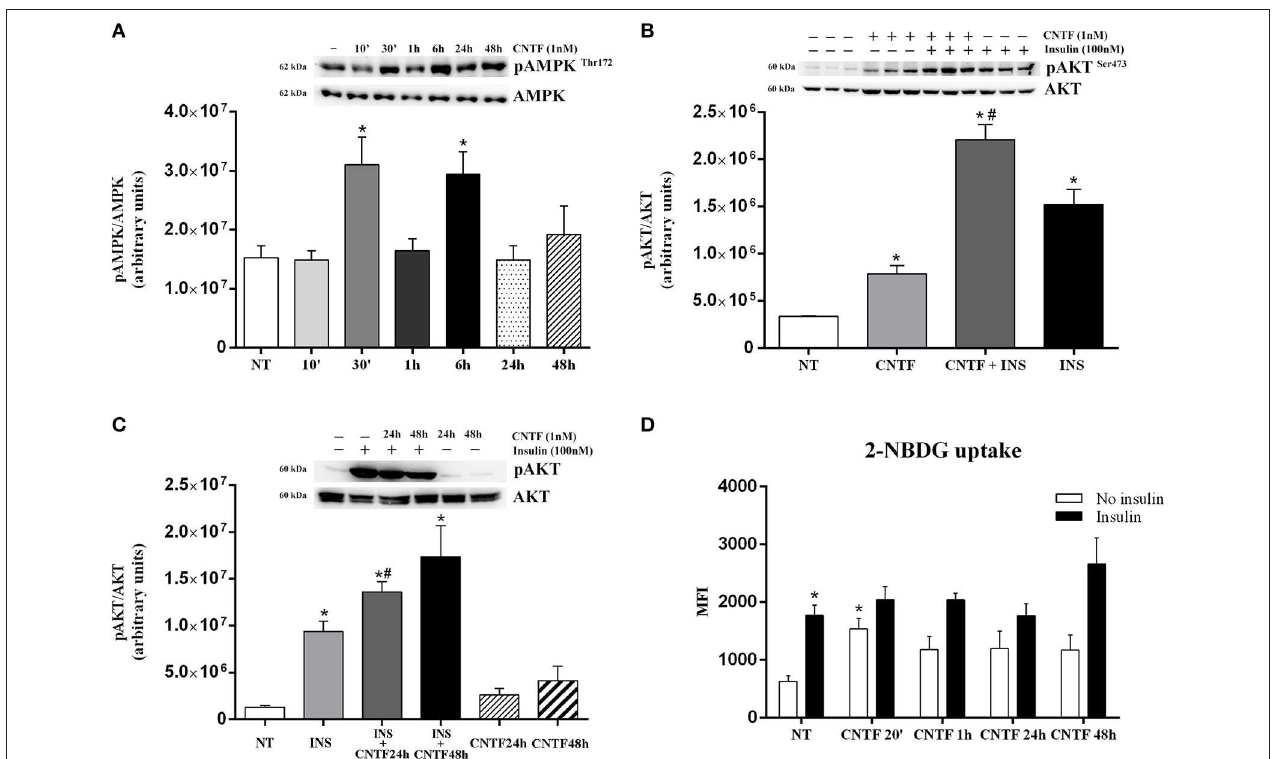
FIGURE 3 | AMPK and AKT pathway activation in hMADS adipocytes by CNTF. (A) Representative immunoblot and quantification of time-dependent 172-threonine AMPK phosphorylation in hMADS adipocytes treated with 1nM CNTF. Data ( n = 3) are mean ± SEM, * p < 0.05 compared with untreated cells (NT). Data were analyzed using one-way ANOVA. (B) Representative immunoblot and quantification of 473-serine AKT phosphorylation in hMADS adipocytes treated with 1nM CNTF for 20min (CNTF); with CNTF and 100nM insulin for 20min (INS); and with insulin alone. Data ( n = 3) are mean ± SEM, * p < 0.05 compared with untreated cells (NT), # p < 0.05 compared with cells treated with insulin alone. Data were analyzed using one-way ANOVA. (C) Representative immunoblot and quantification of 473-serine AKT phosphorylation detected in hMADS adipocytes treated with 100nM insulin for 20min (INS); with 1nM CNTF for 24h (CNTF 24h + INS), or 48h (CNTF 48h + INS); only with CNTF for 24 (CNTF 24h) or 48h (CNTF 48h). Data ( n = 3) are mean ± SEM, * p < 0.05 compared with untreated cells (NT). Data were analyzed using one-way ANOVA. (D) 2-NBDG uptake, expressed as mean fluorescent intensity (MFI), detected in hMADS adipocytes treated with 1nM CNTF alone applied for different periods (white bars) or else with 100nM insulin for 10min (black bars). Data ( n = 3) are from three independent experiments and are mean ± SEM, * p < 0.05 compared with untreated cells (NT). Data were analyzed using Student’s t